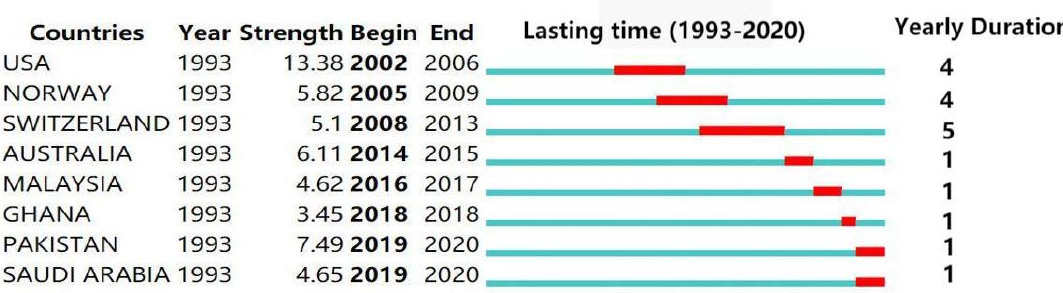
Figure 6. Countries with occurrence explorations during 1993–2020.